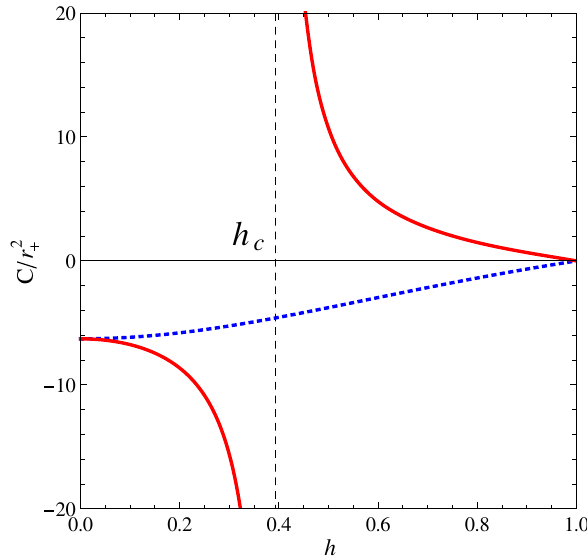
Fig. 1 Plots of the heat capacities C J (red solid line) and C Ω (blue dotted line) against h . C J diverges at h c where a pole